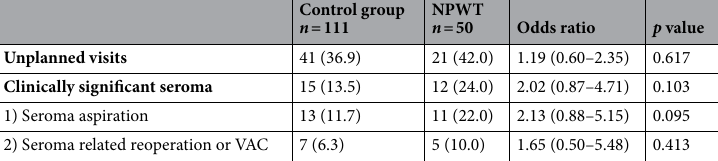
Table 3. Secondary outcomes: number of patients requiring unplanned visits and developing CSS